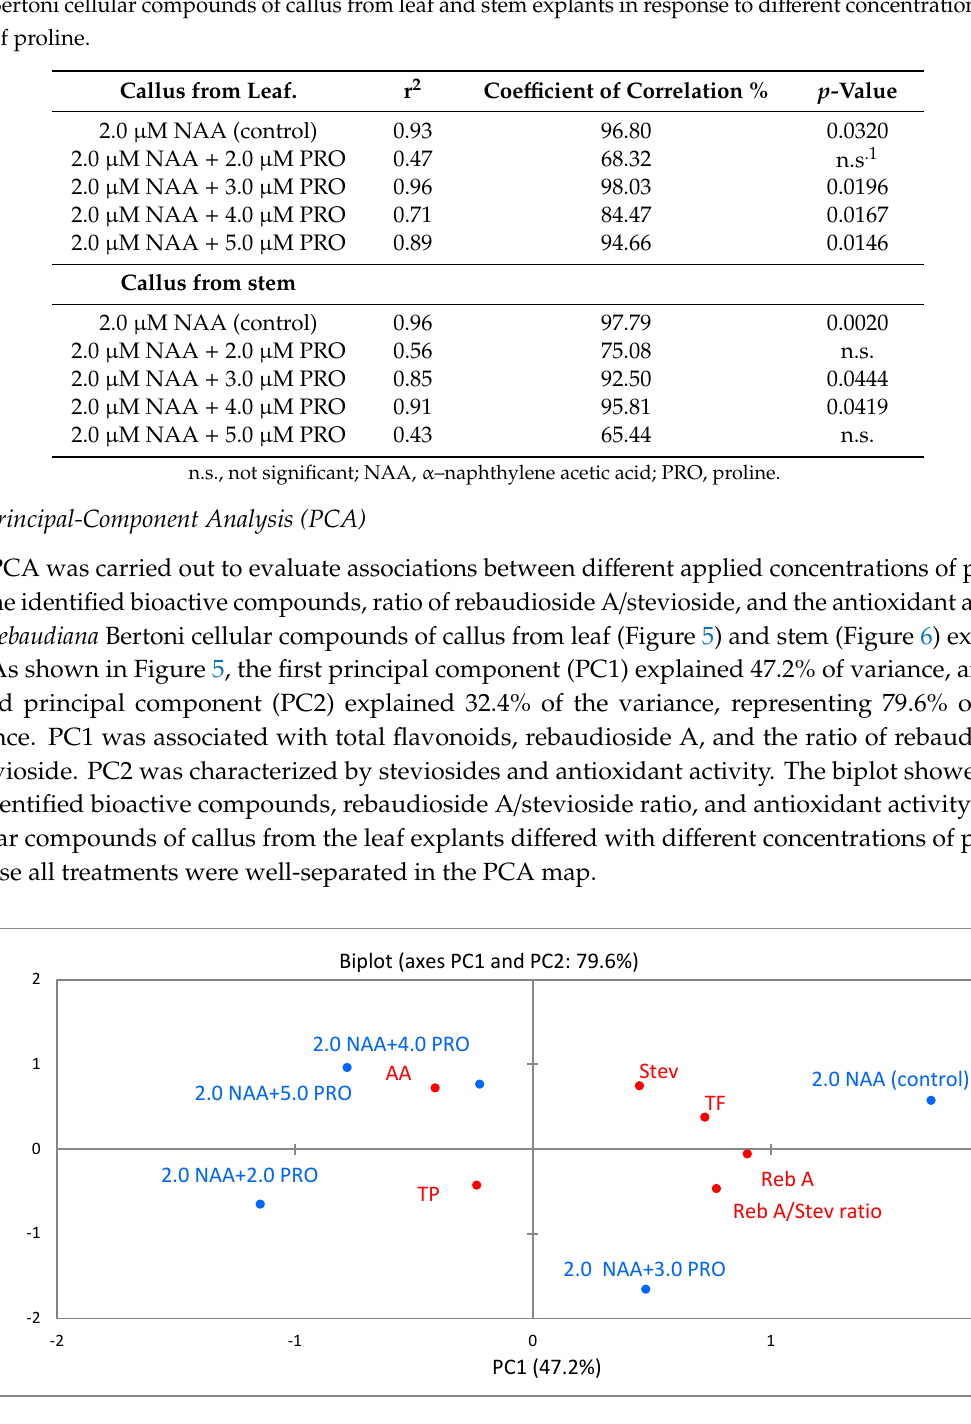
Figure 5. Principal-component analysis ( PCA) for total phenolics (TP), total flavonoids (TF), stevioside (Stev), rebaudioside A (Reb A), rebaudioside A/stevioside ratio, and antioxidant activity (AA) in cellular compounds of callus from leaf explants influenced by different concentrations and combination of α -naphthalene acetic acid (NAA) and proline (PRO) (2.0 μ M NAA (control), 2.0 μ M NAA + 2.0 μ M PRO, 2.0 μ M NAA + 3.0 μ M PRO, 2.0 μ M NAA + 4.0 μ M PRO, and 2.0 μ M NAA + 5.0 μ M PRO).